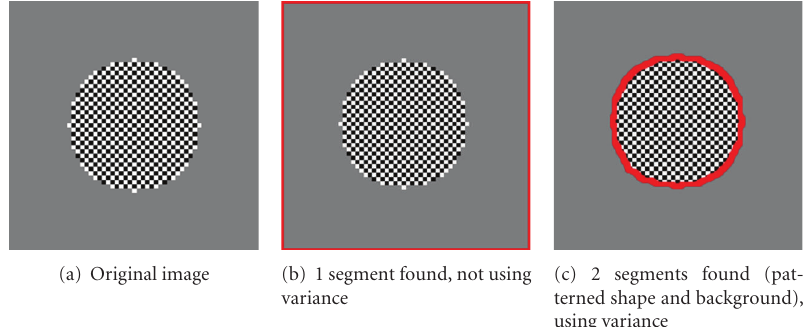
Figure 6: Parameters used: (b) n = 60, α = 10, (cid:7) α = 10, θ = 0 . 1, γ = 0 . 1, d 1 = 0 . 15, σ = 5; (c) n = 60, α = 10, (cid:7) α = 10, β = 10, θ = 0 . 1, γ = 0 . 1, d 1 = 0 . 15, σ = 5, ρ = 1.